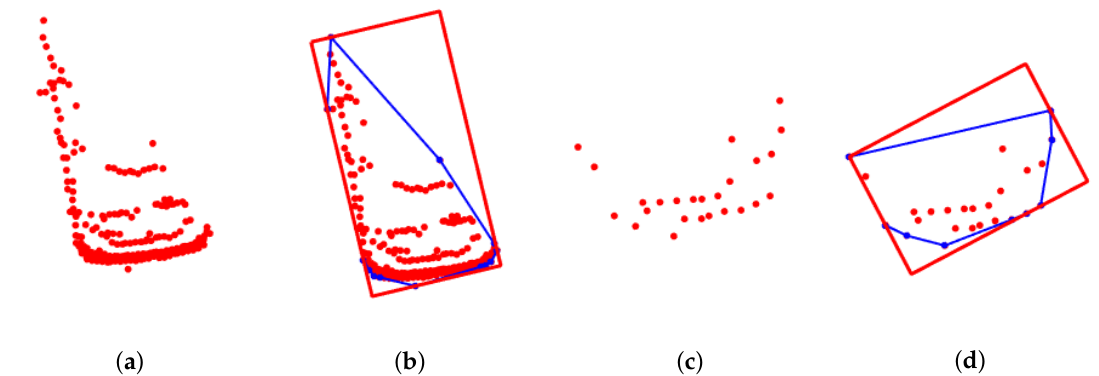
Figure 1. Convex-hull model-fitting results with multifactor objective function. ( a , c ) Original point-clouds of two vehicles. ( b , d ) Corresponding fitted bounding box with the convex-hull model. Blue lines show the convex hull of the point-cloud